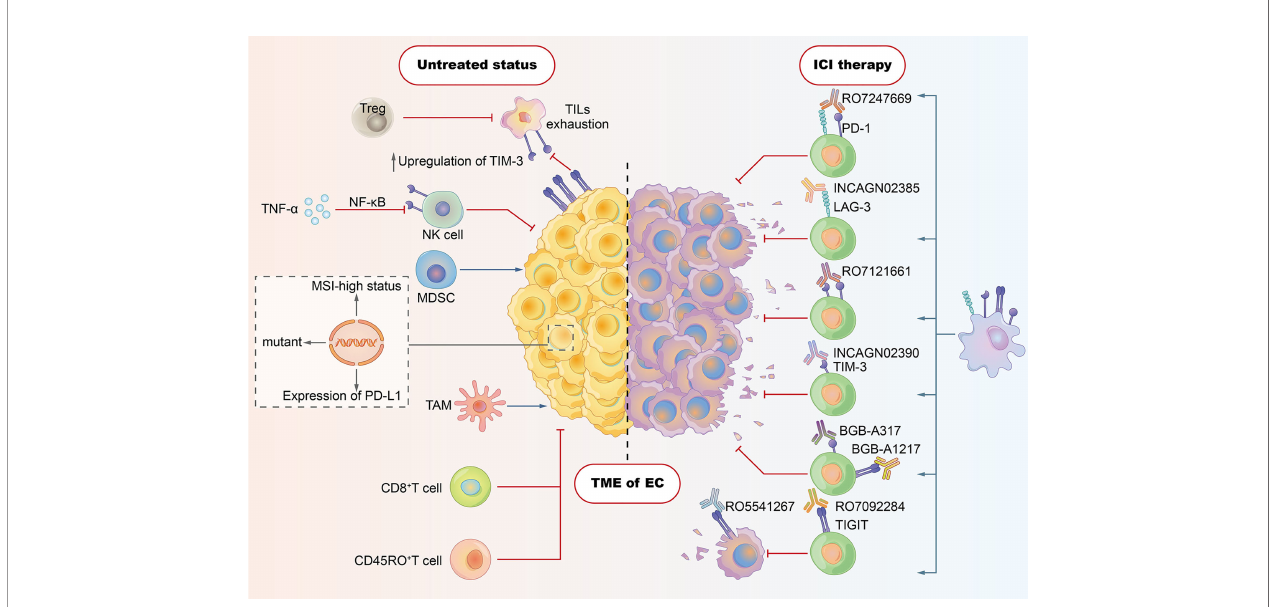
FIGURE 1 | Tumor microenvironment (TME) in esophageal cancer: tumor cells evade host immunity via a series of cell-extrinsic factors that comprise the TME. Immune checkpoint inhibitors (ICIs) are designed to reverse the TME of immunosuppressive effects, thereby enhancing patients ’ immune responses against tumors. As shown in the left section, CD8 + T cell, CD45RO + T cell, and NK cell contribute to the antitumor immune response. However, some subsets of cells with negative immunomodulatory function play crucial roles in suppressing antitumor effects. Regulatory T cells (Tregs) have been shown to dampen the activity of tumor-in fi ltrating lymphocytes (TILs). Tumor-associated macrophages (TAMs) and myeloid-derived suppressor cells (MDSCs) also boost the immune evasion of tumor cells. Some tumor cell – intrinsic factors (e.g., PD-L1 expression, tumor mutation load, and MSI-high status) account for the cancer resistance to ICIs. The expression of ICI such as TIGIT and PD-1 may be associated with the exhaustion of TILs. Induced frequency of NK cells in EC is ascribed to TNF- a , which is able to induce the expression of TIM-3 via the NF- k B signaling pathway. The right section depicts the novel ICIs strategies targeting LAG-3, TIM-3, and TIGIT, which aim to reverse the exhaustion or dysfunction states of T